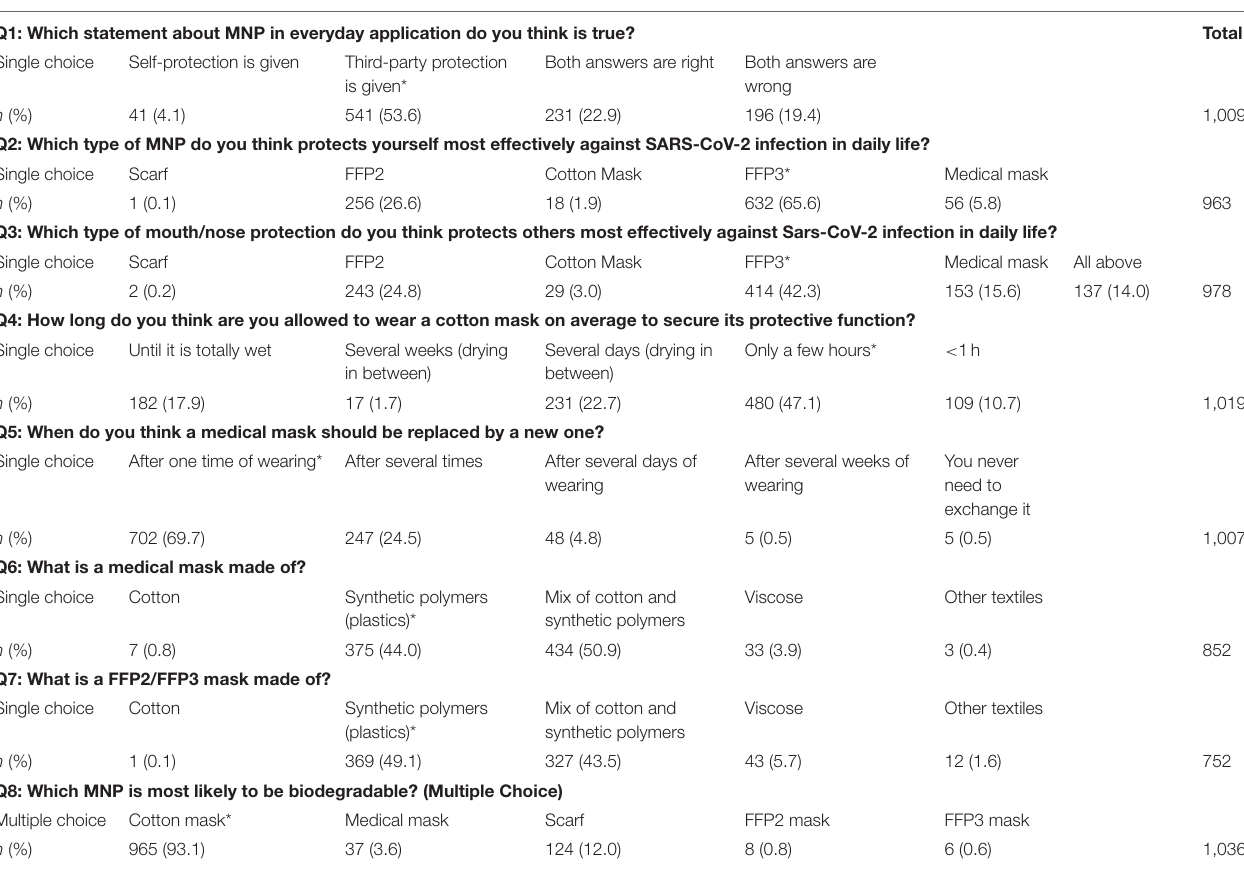
TABLE 3 | Questions operationalizing the knowledge level on different types of